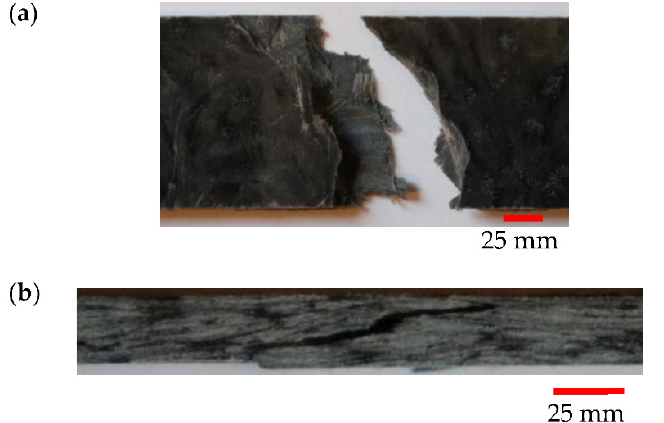
Figure 5. Fracture faces of the tensile tested aggregate-reinforced composite specimen: ( a ) top view, ( b ) side view.